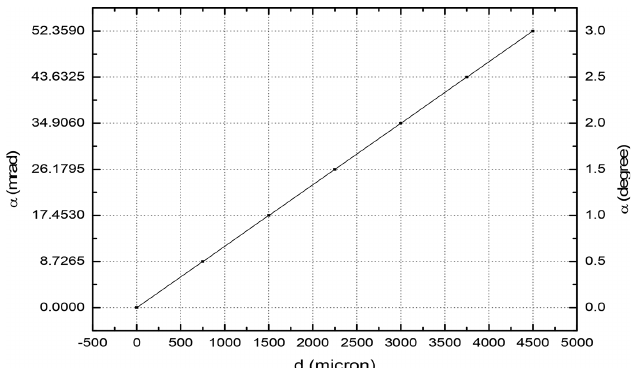
Figure 11 Calibration curve: angle versus displacement.